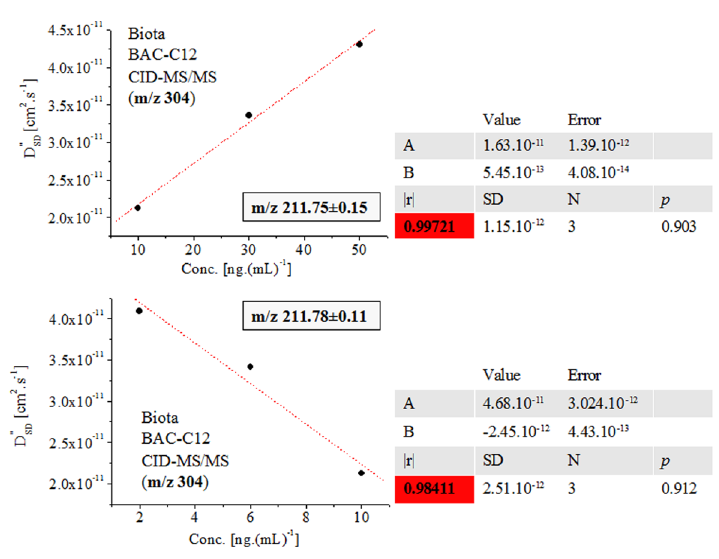
Figure 6. Linear functional relation D″ S D = f(conc.) of fragmentation ions at m / z 211.75 and 211.78 of SRM spectra of molecular cation [M] + at m / z 304 of surfactant BAC-C12 in biota; chemometrics.